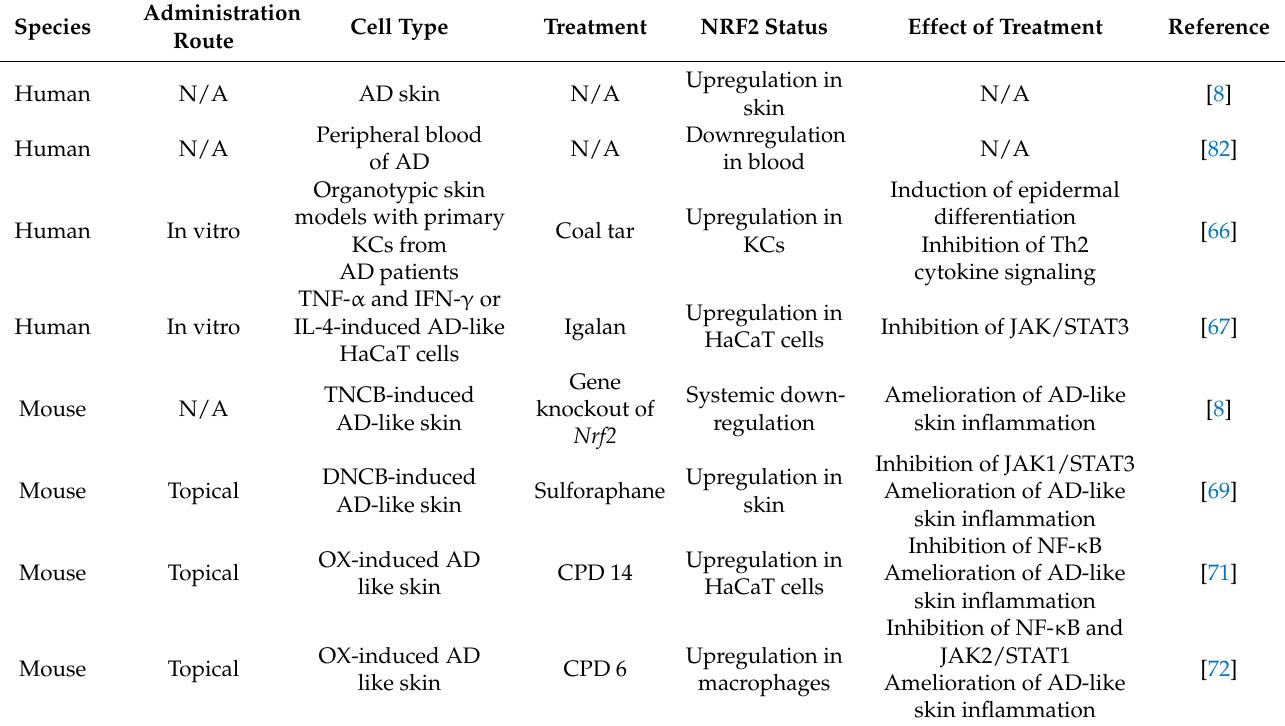
Table 1. NRF2 and atopic